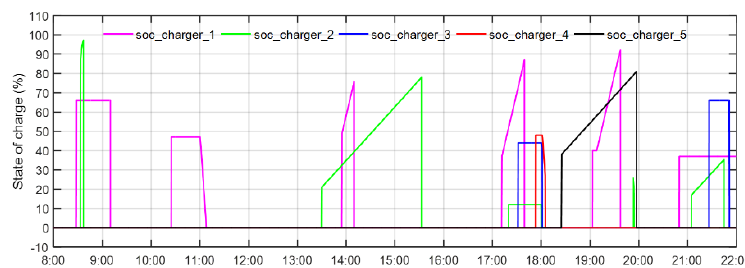
Figure 14. State of charge soc EV evolutions under ICDA. Figure 14. State of charge 𝑠𝑜𝑐 𝐸𝑉 evolutions under ICDA. Figure 14. State of charge 𝑠𝑜𝑐 𝐸𝑉 evolutions under ICDA. Figure 14. State of charge 𝑠𝑜𝑐 𝐸𝑉 evolutions under ICDA.